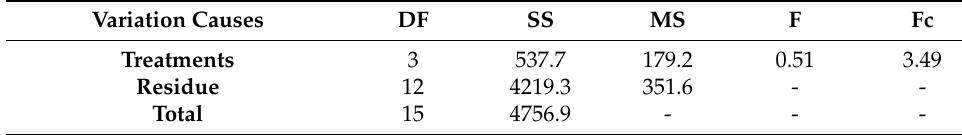
Table 2. Analysis of variance